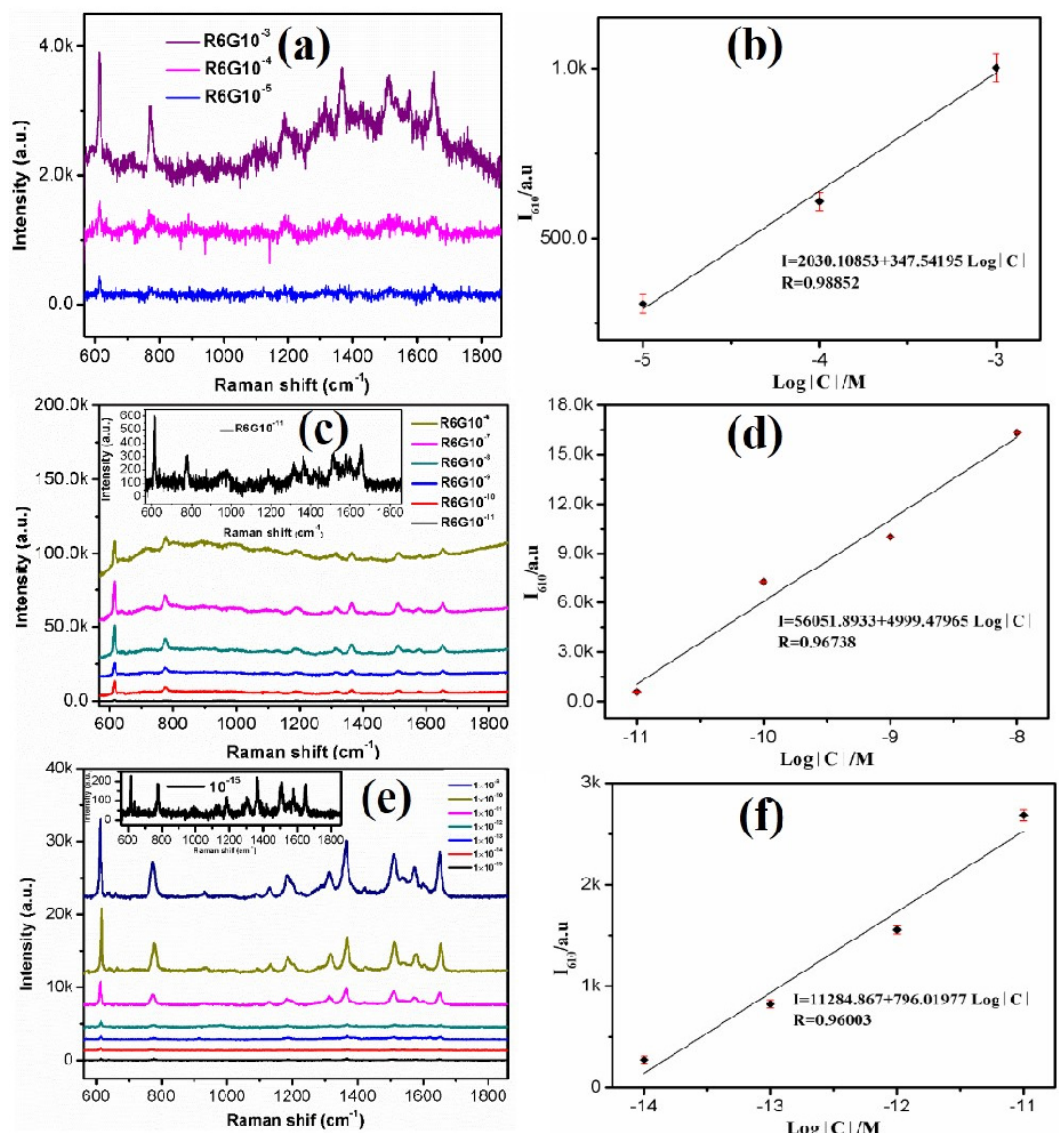
Figure 4. Surface enhanced Raman scattering (SERS) spectra of rhodamine 6G (R6G) with di ff erent concentrations on the di ff erent substrates: ( a , b ) 1.0 × 10 − 3 –1.0 × 10 − 5 M on the CuO FM substrate; ( c , d ) 1.0 × 10 − 6 –1.0 × 10 − 11 M on the Ag nanoparticles (NPs); ( e , f ) 1.0 × 10 − 9 –1.0 × 10 − 15 M on